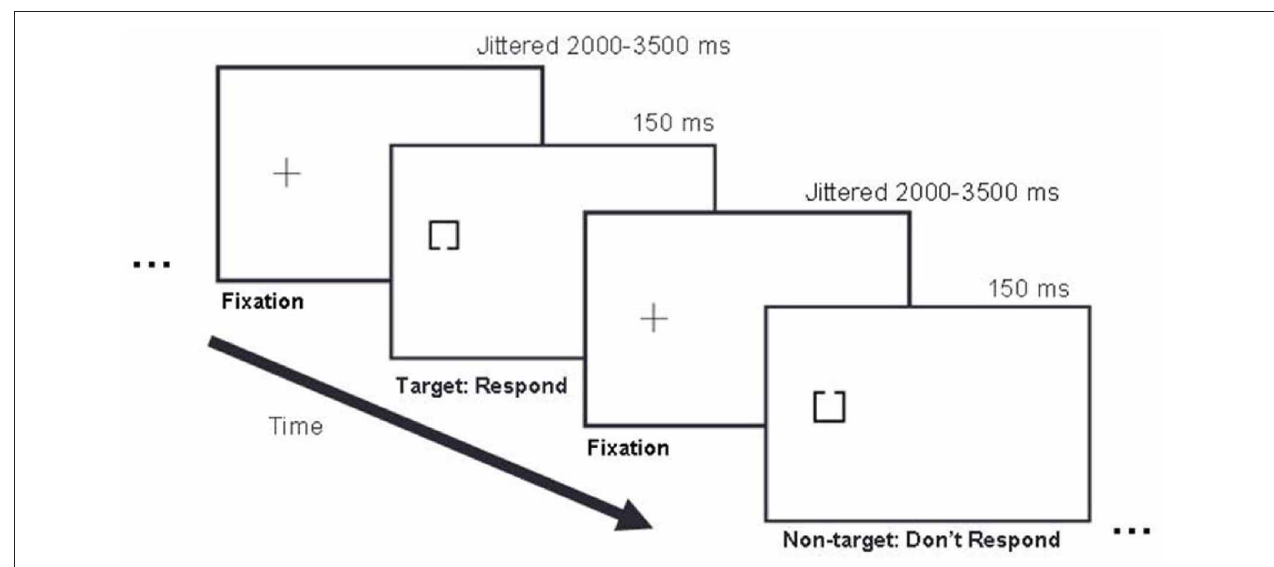
FIGURE 2 | Example trial sequence. In this left stimulus side example, a fixation cross appeared on the left side of the display for 2000–3500ms, followed by either a target or non-target stimulus presented for 150ms,